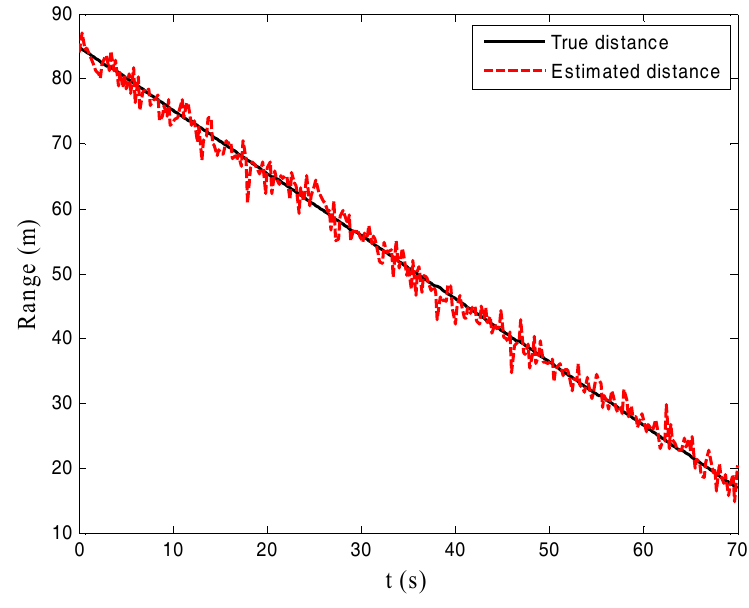
Figure 1. True trace and the estimated range.